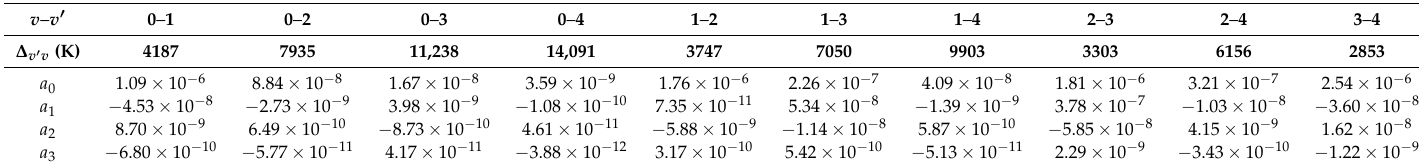
Table 3. Parameters a 0 , a 1 , a 2 , and a 3 of the fitting polynomials P fit pairs of initial and final vibrational levels for which the parameters are fitted. For convenience, we also specify (the second line of the header) the threshold energy ∆ v (cid:48) v for the excitation process of the corresponding pair. For all excitation and de-excitation processes, the same parameters a i are used in Equations (4) and (5).